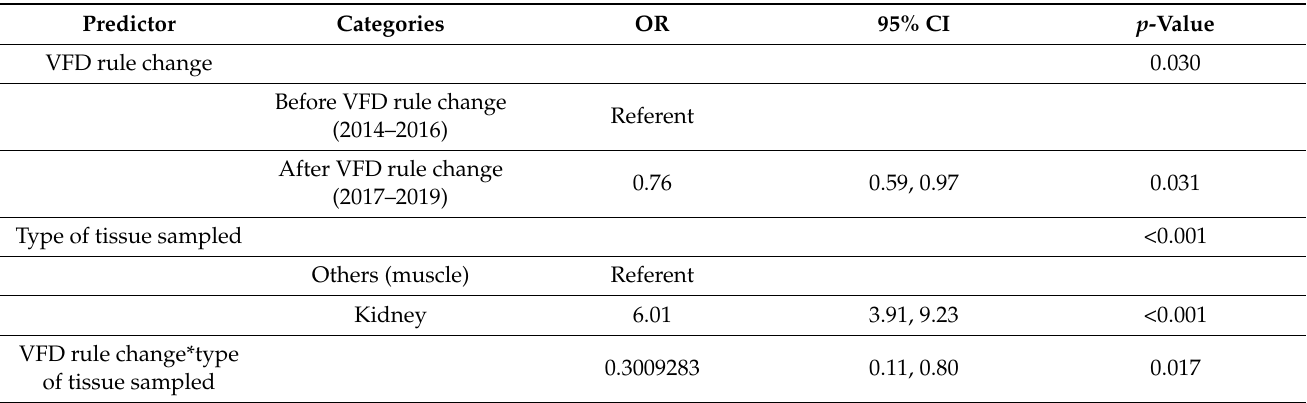
Table 4. Results of multivariable logistic regression for predictors of detection of violative residues of penicillin in the tissue of food animals ( n = 1310) from the IGS,